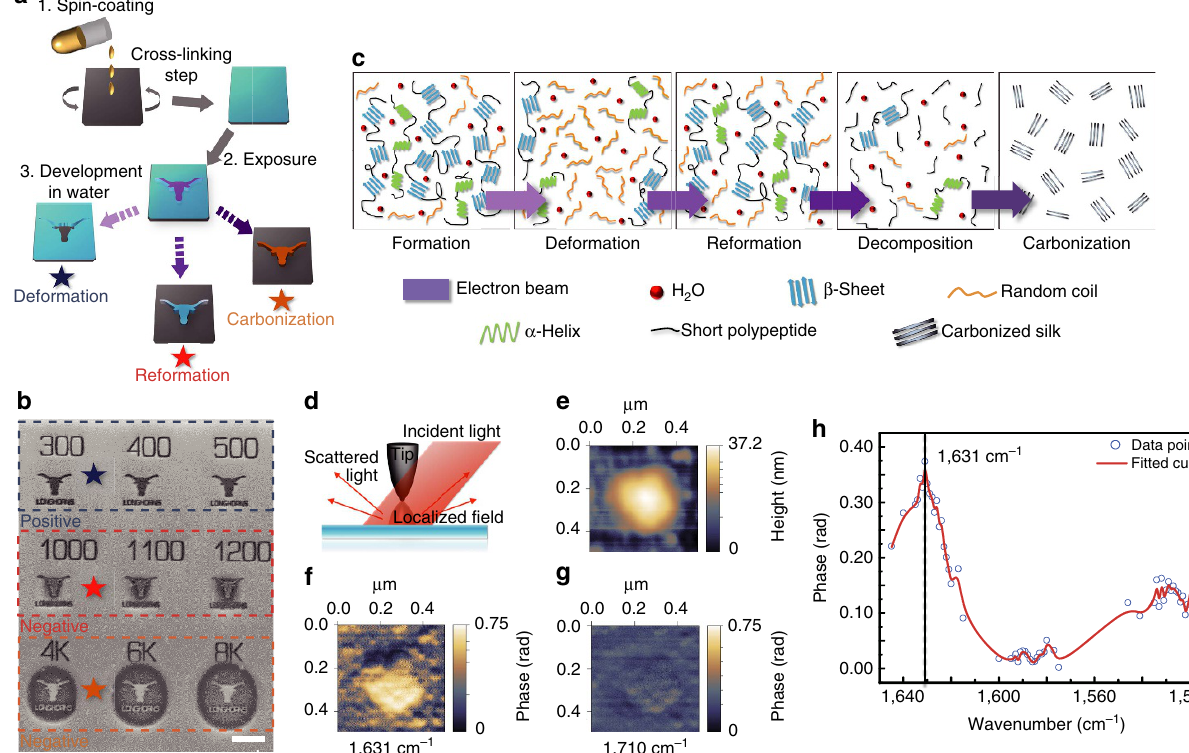
Figure 1 | Electron-regulated nanoscale structural transitions in silk proteins. ( a ) Silk proteins as dual-tone bio-resist in EBL. ( b ) SEM images of nanopatterned crystalline silk as positive or negative resist on the same substrate (due to different structural transitions) depending on ebeam dosages. Scale bar, 5 m m. ( c ) Schematic illustration of b -sheet-oriented structural transitions regulated by electron energies. ( d ) Schematics of nanoscale IR spectroscopic imaging using scattering-type SNOM (s-SNOM). ( e ) Topography of silk nano-aggregates ( b -sheet rich) on a silicon substrate. ( f , g ) Near-field IR phase images at 1,631 and 1,710cm (cid:2) 1 , respectively. ( h ) Local IR absorption spectra (symbols) depicting the normalized near-field phase signal of crystalline silk by sweeping the output wavenumber of the QCL and using IR nano-spectroscopic (Supplementary Fig. 5) and thickness (Fig. 2b) of as-fabricated silk nanostructures that underwent the radiolysis and pyrolysis processes—dominant at low and high dosages—respectively.